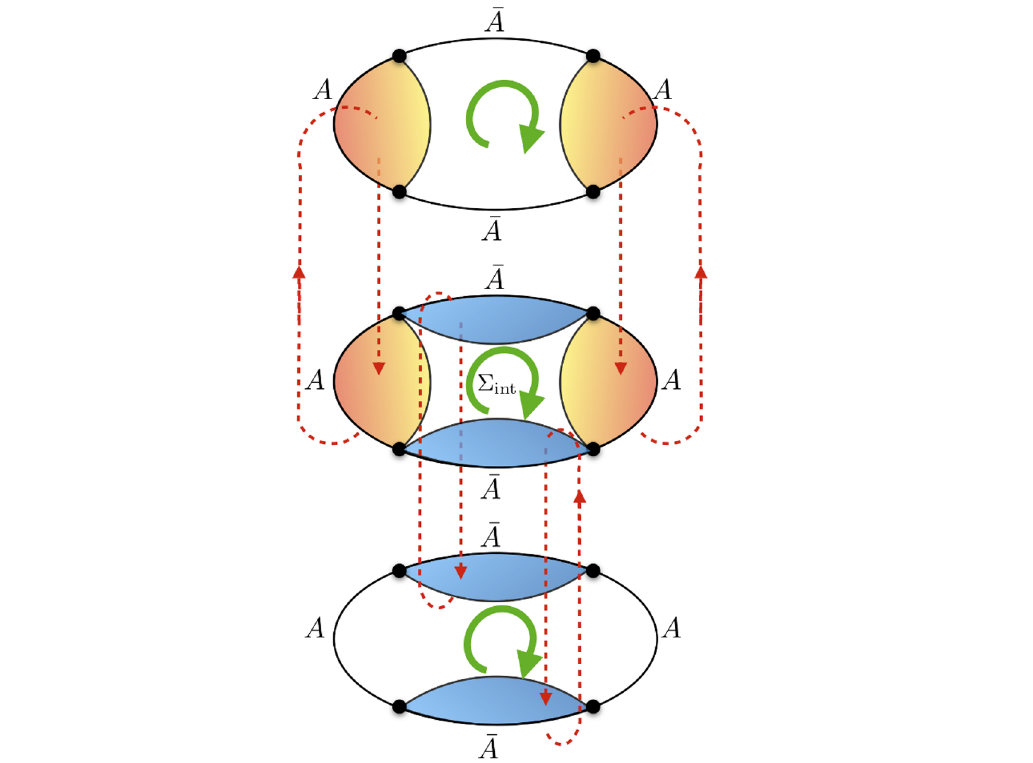
Figure 8 . In the case of two-interval subsystem A in AdS 3 = CFT 2 , the topology for a replica- nonsymmetric saddle for n =